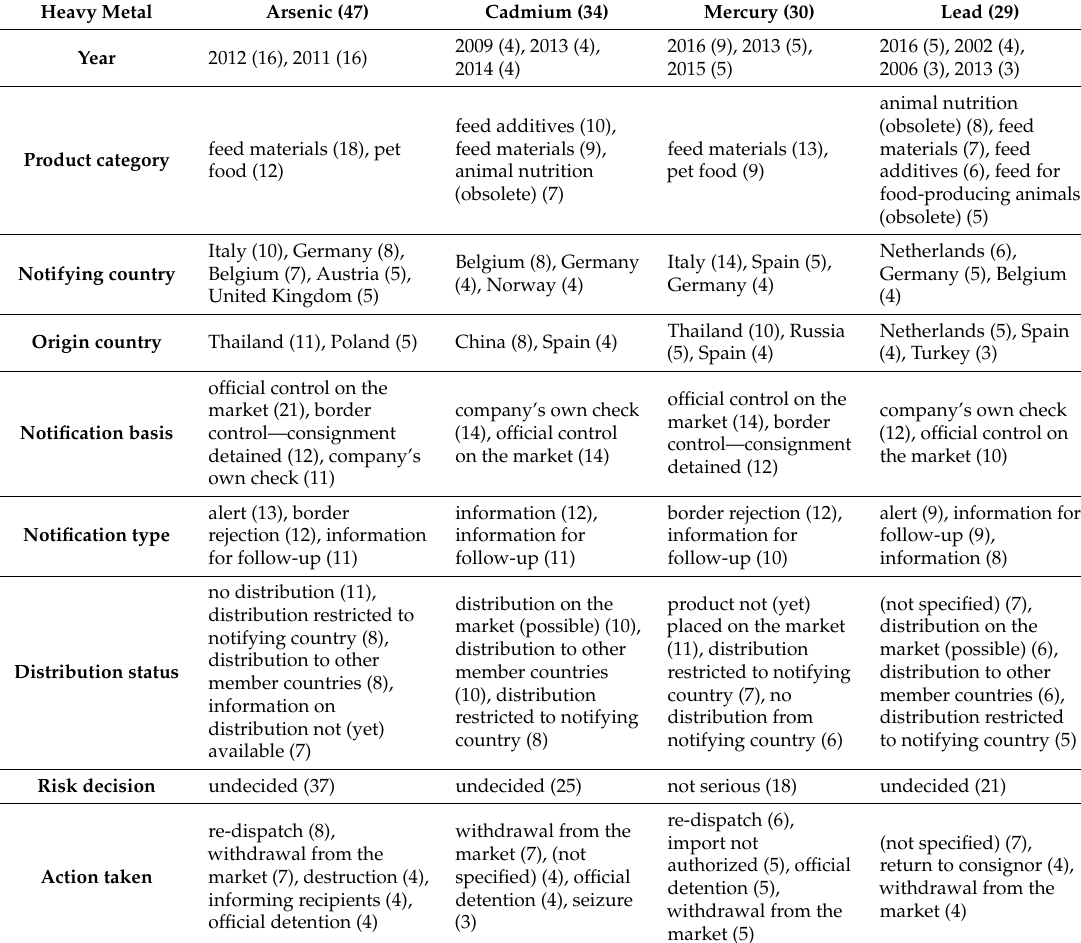
Table 3. Numbers of notifications of heavy metals within feed.